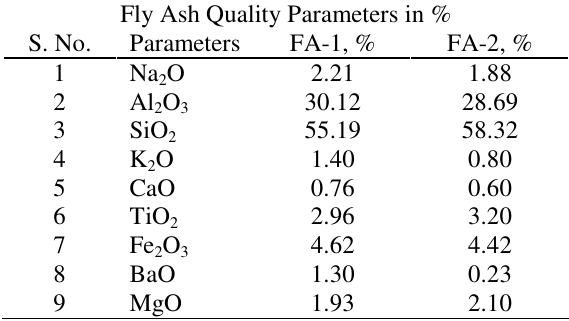
Table 2. XRF analysis report of the fly ash which generated from the thermal power plants which uses the above f-grade